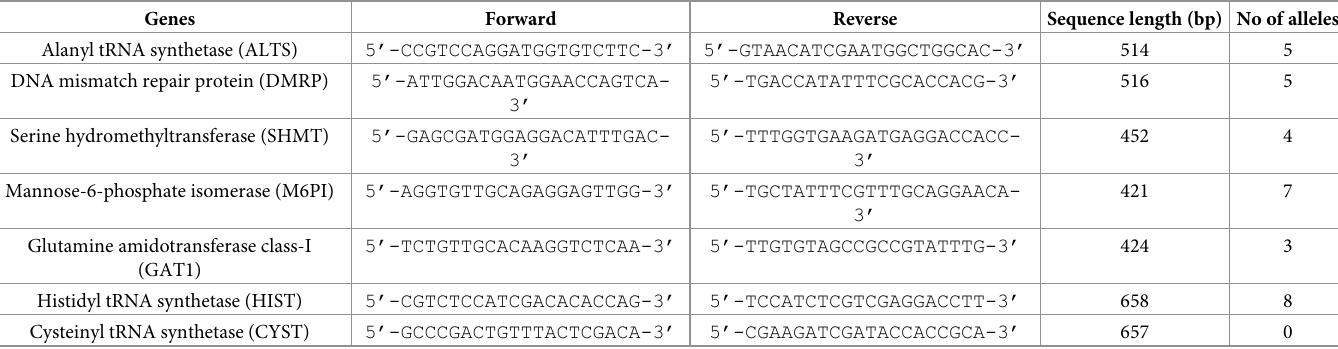
Table 1. Primers used for multilocus sequence typing genes of Trichomonas tenax .